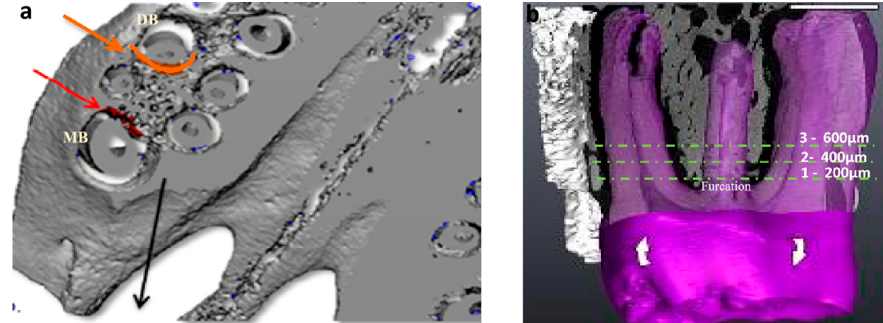
Figure 1. ( a ) Micro-CT section that illustrates the tension and pressure areas around the roots of the maxillary left first molar. The orange arrow and line show the pressure area in relation to the disto-buccal (DB) root, and the red arrow and line indicate the tension area in relation to the mesio-buccal (MB) root. The black arrow indicates the direction of the orthodontic tooth movement; ( b ) An illustration of the locations of the histological sections. Sections were performed on a transversal plane of the maxilla, and each section contained the entire maxillary jawbone. The sections were taken at three locations (1, 2, 3) through the roots of the first maxillary molar: location 1 = 200 μ m apical to the root furcation, location 2 = 400 μ m, and location 3 = 600 μ m. This yielded a total of three slides per maxilla.